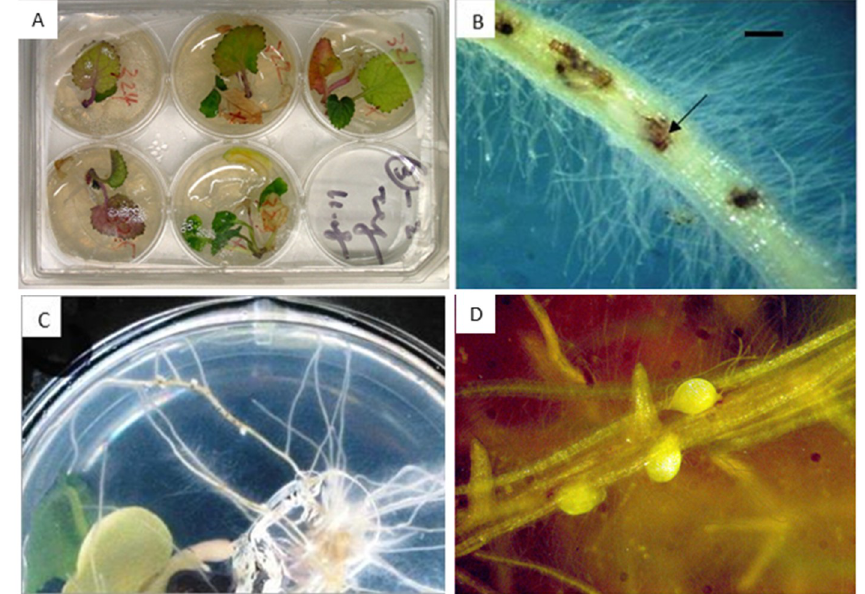
Figure 4. Beet cyst nematode resistance analysis in vitro. ( A ) The kanamycin resistance transgenic plants were planted on the six-well plate with KNOP medium. ( B ) Second stage juveniles (J2s) were inoculated near the plant root and larval penetration could be seen in the oilseed rape roots (dark arrow). The black bar equals 500 µ m. ( C ) Female cyst nematode developed on the root surface after 21 days of inoculation with J2. ( D ) The stereo microscope figures of developed female on oilseed rape root.